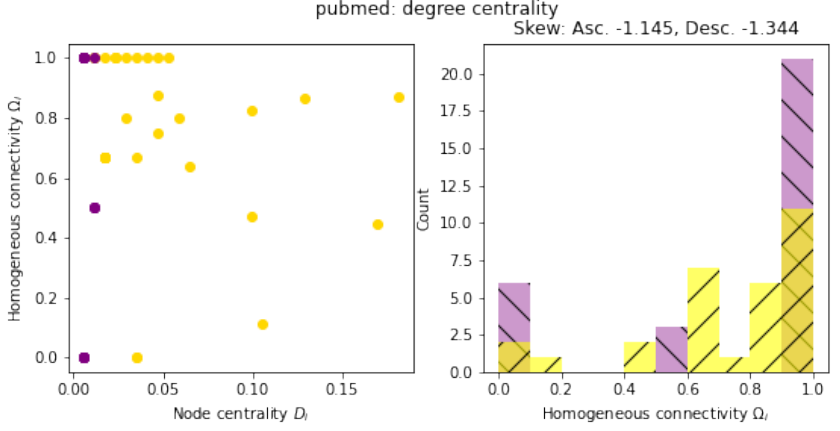
Figure 3. Low CV d networks (Pubmed) graphs have lower accuracies when sampling nodes from the lowest to highest score (i.e., ‘ascending’ methods), showing that the ranking algorithms are inversely beneficial to the node classification task.